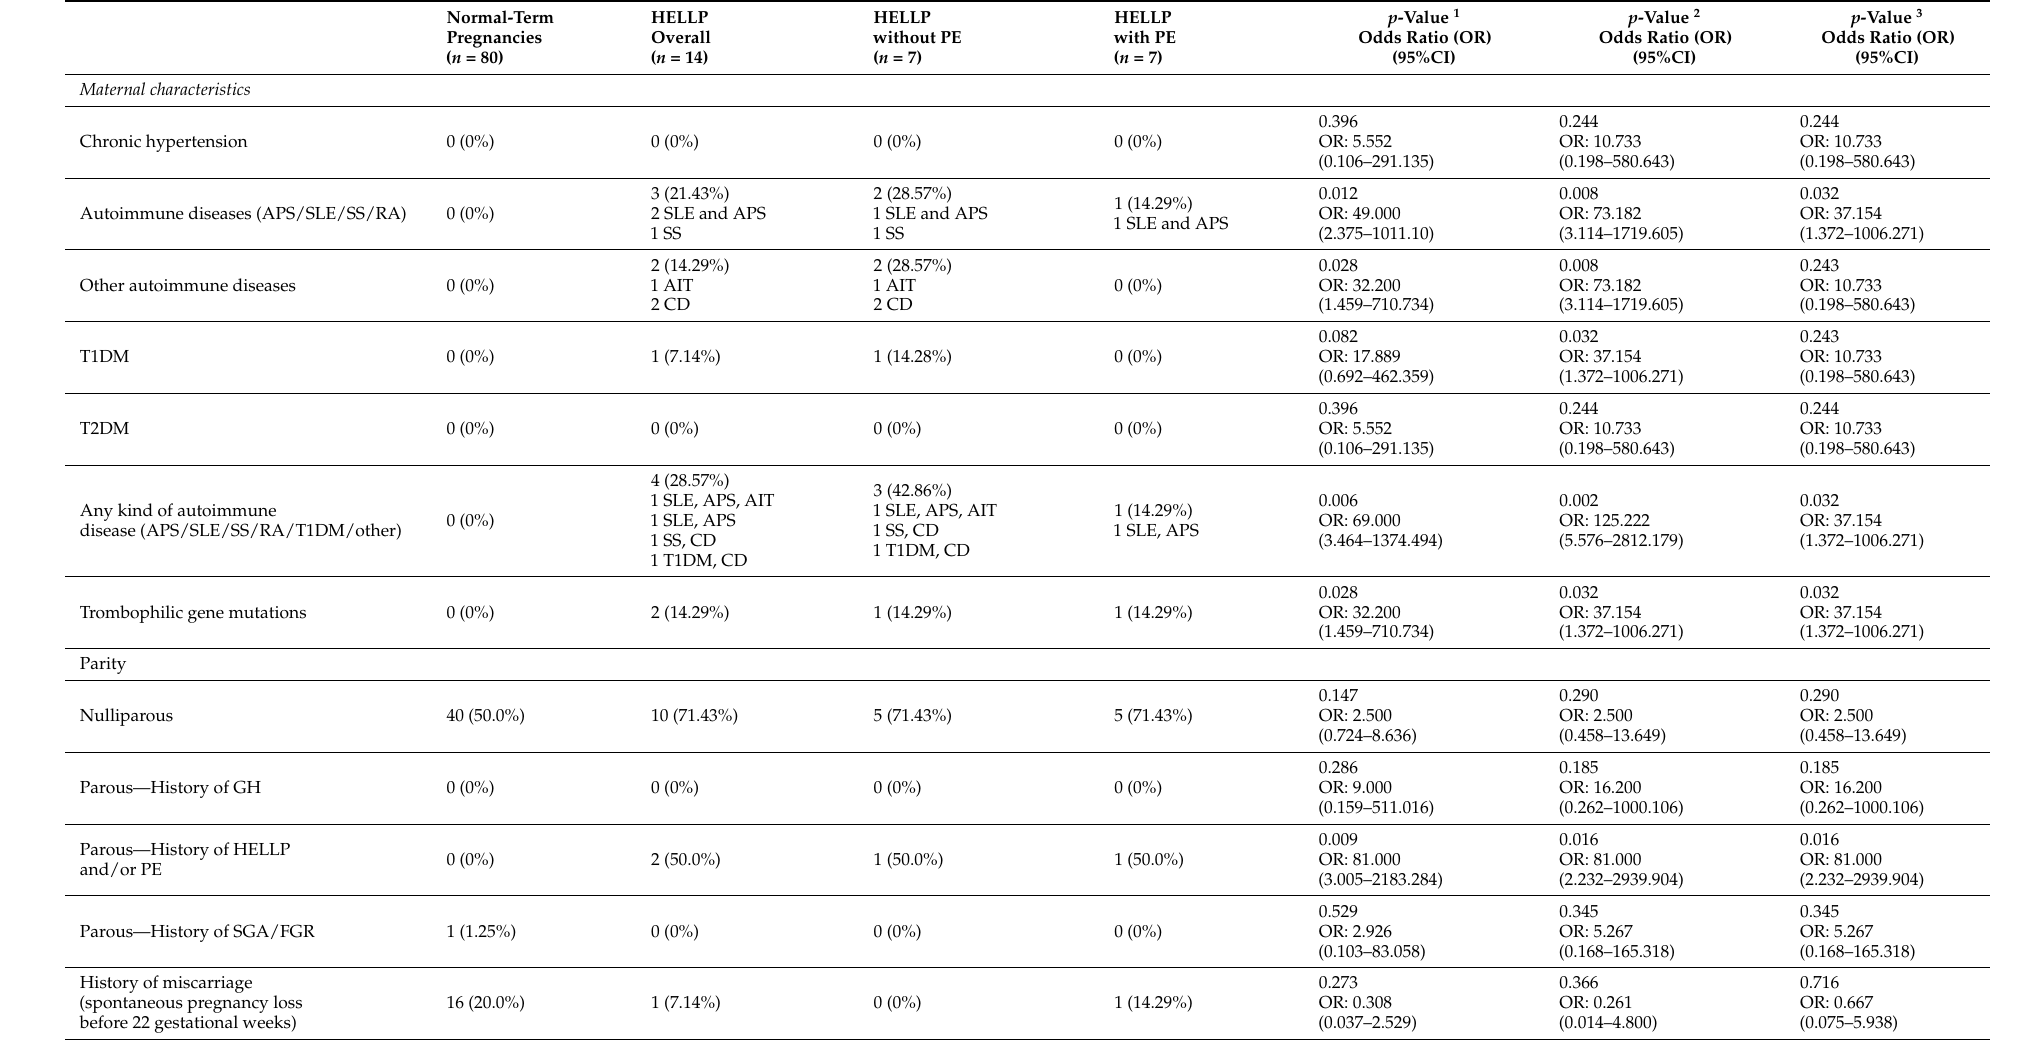
Table 2. Clinical characteristics of the study and control